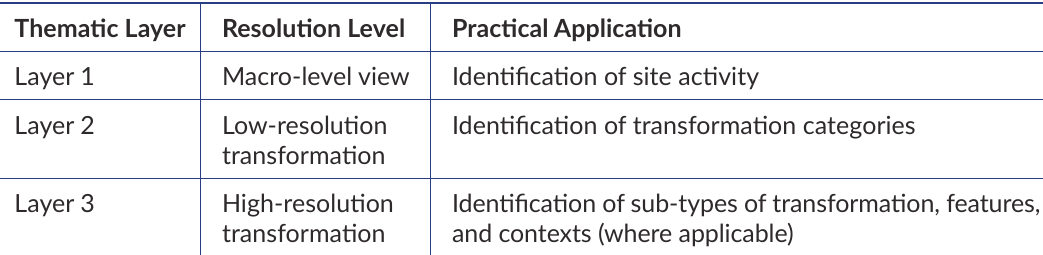
Table 2: The resolution system utilised in this methodology, laid out with the practical considera- tions in its construction (J.